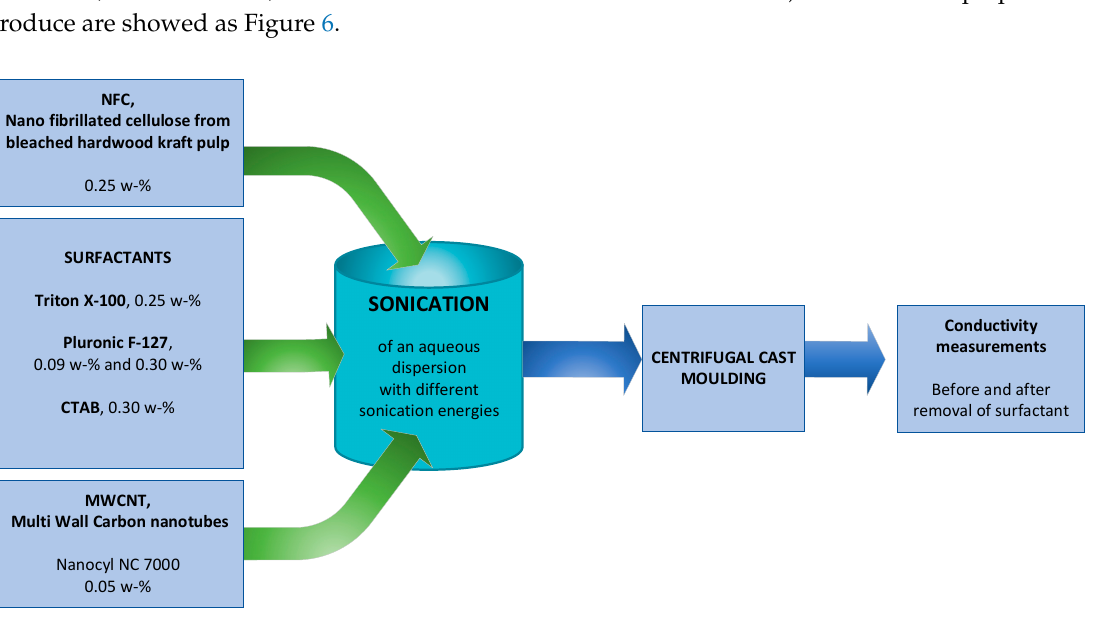
Figure 6. Preparation procedure of NFC-CNT dispersion and nanocomposite films.